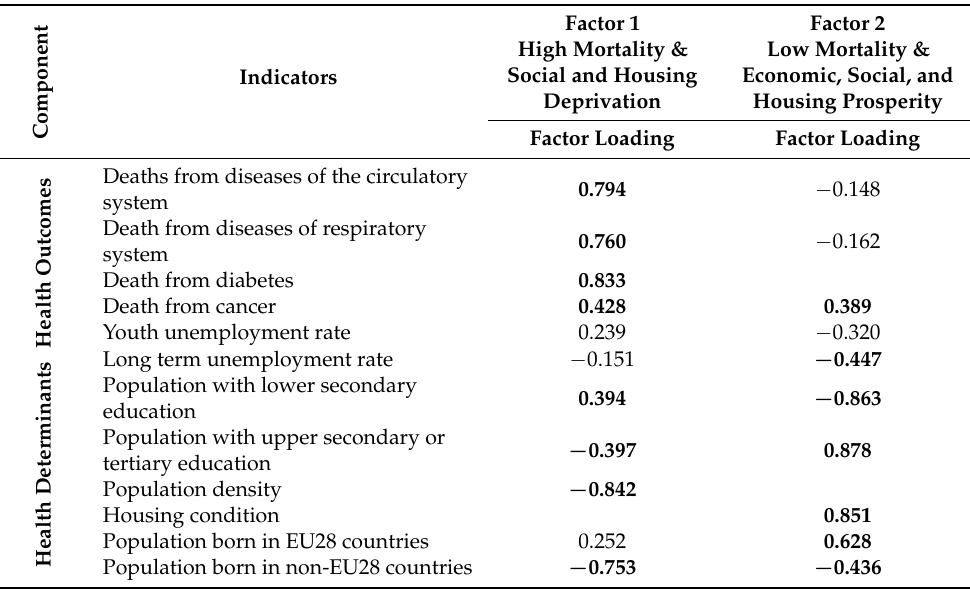
Table 3. Lisbon municipalities factor